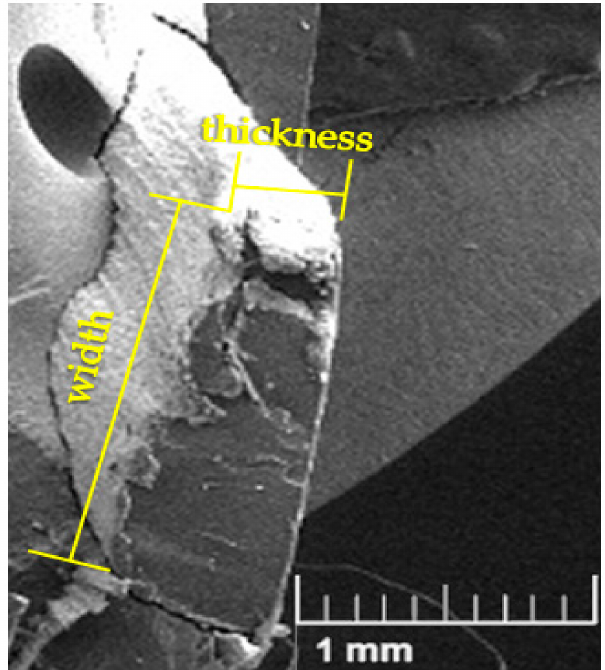
Figure 4. Scanning electron microscopy (SEM) image of an untreated ra ffi a fiber